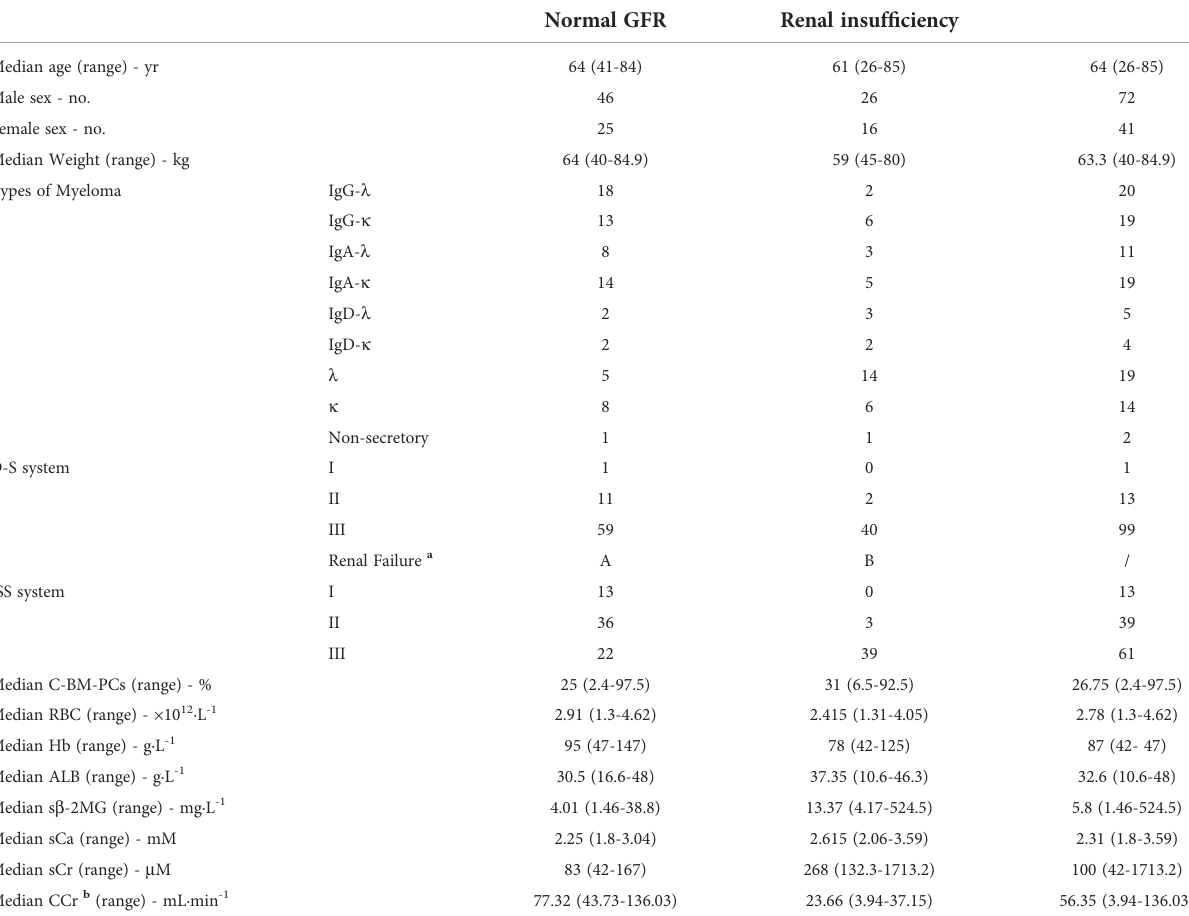
TABLE 1 Clinical data of multiple myeloma with osteolytic bone lesions.